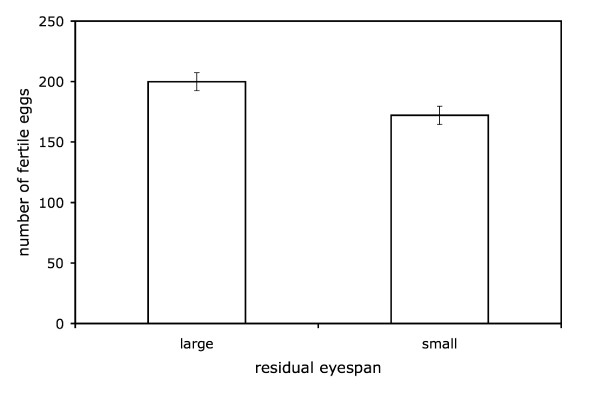
The effect of male eyespan on fertility. Least squares means ± s.e. number of fertile eggs laid in 32-day period following mating (at average levels of fecundity) by large residual eyespan and small residual eyespan males.